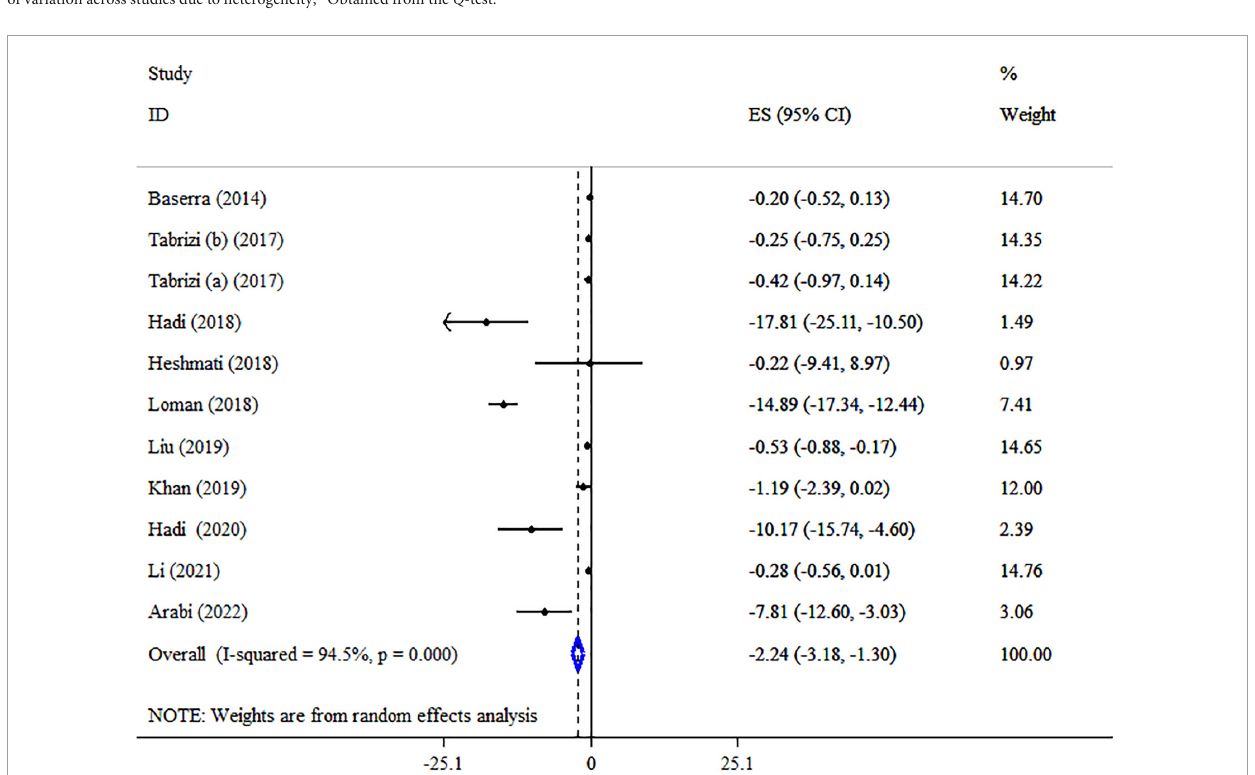
of the activation of hydroxymethyl glutaryl CoA reductase (HMG-CoA reductase), a rate-limiting enzyme in the cholesterol synthesis pathway (72). Other possible mechanisms regarding the cholesterol-lowering property of synbiotics include the following: conversion of cholesterol into coprostanol (73) and integrating cholesterol in cellular membranes (74). Besides, synbiotics could alleviate lipid profile levels via decreasing the secretion of VLDL, insulin resistance, inflammation, and de novo lipogenesis